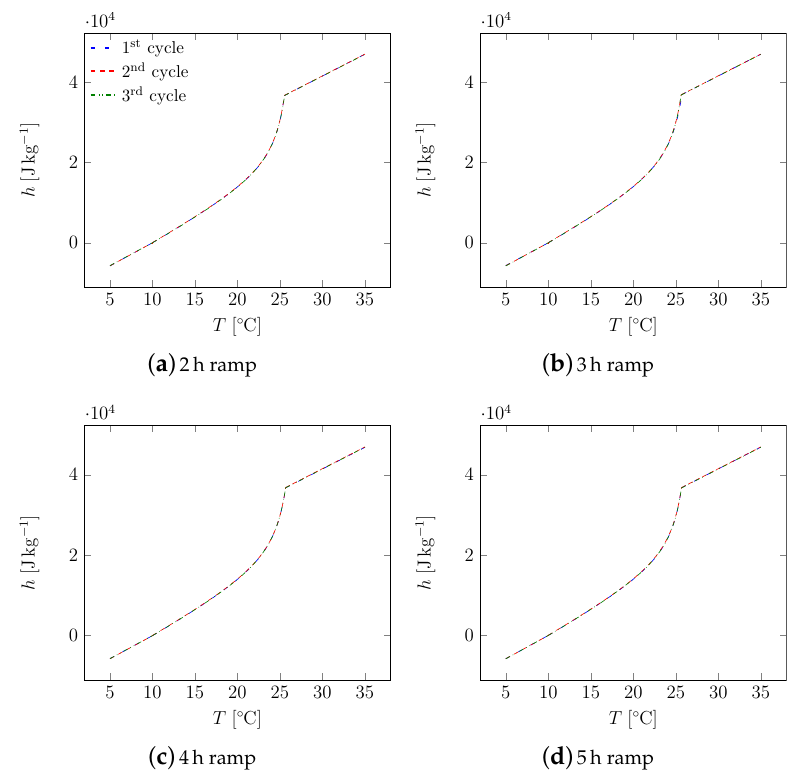
Figure A14. 22.1% w -PCM mortar: comparisons of the identified enthalpy functions with respect to the heating/cooling ramp ( n.b. unique formulation pertaining for both fusion and